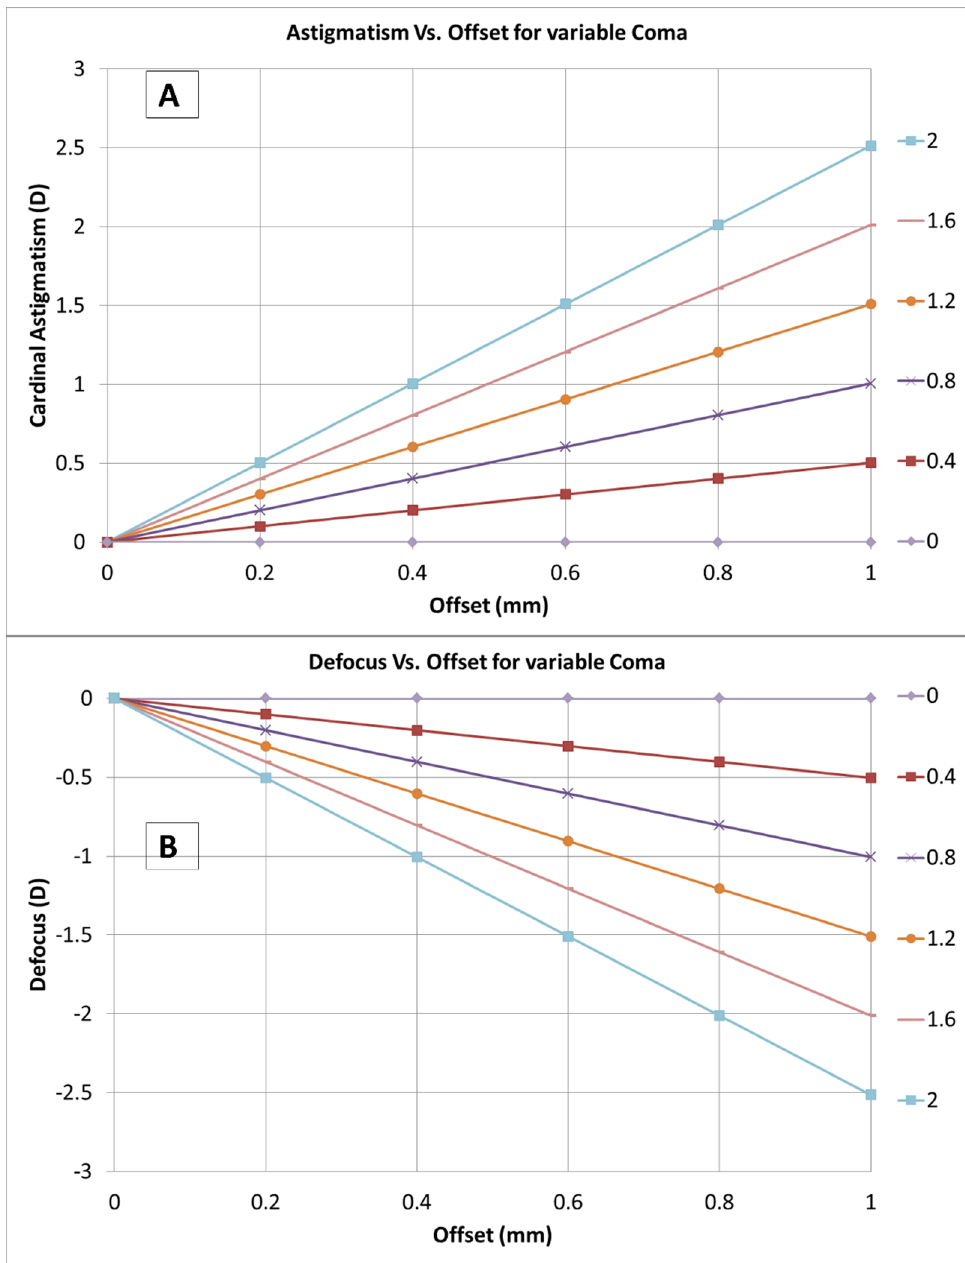
Figure 4. A progression of aberrations with respect to offset (0 to +1 mm) for a variable amount of horizontal coma (C[3,1]) (0 to +2 µm). Here, offset represents translation; however, the results are presented with the terminology more popular in the field of refractive surgery. ( A ) Progression of cardinal astigmatism with respect to offset for variable horizontal coma (C[3,1]). For a horizontal coma (C[3,1]) of +0.4 µm, a translation of +1 mm theoretically results in +0.5D of cardinal astigmatism. ( B ) Progression of defocus with respect to offset for variable horizontal coma (C[3,1]). For a horizontal coma (C[3,1]) of +0.4 µm, a translation of +1 mm theoretically results in − 0.5D of defocus.